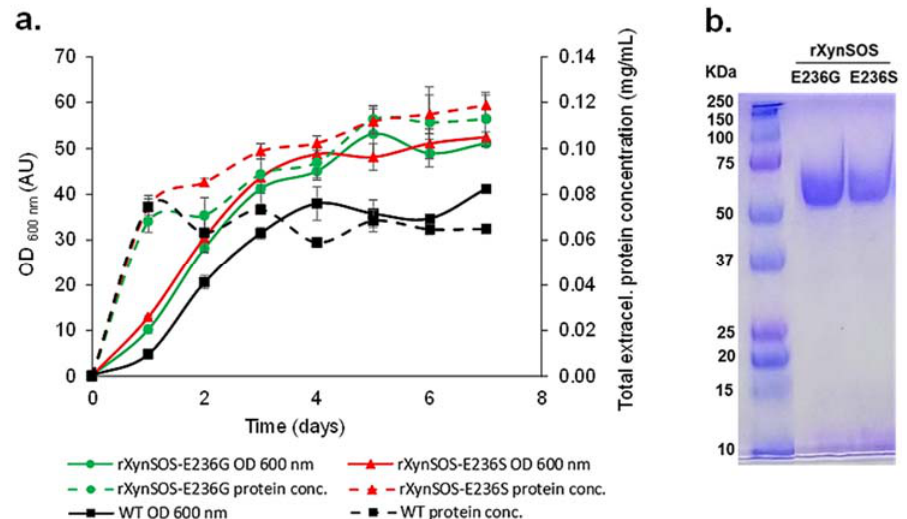
Figure 2. Production and purification of rXynSOS-E236G and rXynSOS-E236S glycosynthase variants. ( a ) Total extracellular protein concentration and OD 600 nm of wild-type (WT) P. pastoris and the selected rXynSOS-E236G and rXynSOS-E236S-producing clones. Cultures were grown for 7 days in YEPS medium with methanol induction. ( b ) SDS-PAGE analysis of purified rXynSOS-E236G (lane 2) and rXynSOS-E236S (lane 3) variants. Molecular weight marker is displayed in lane 1.